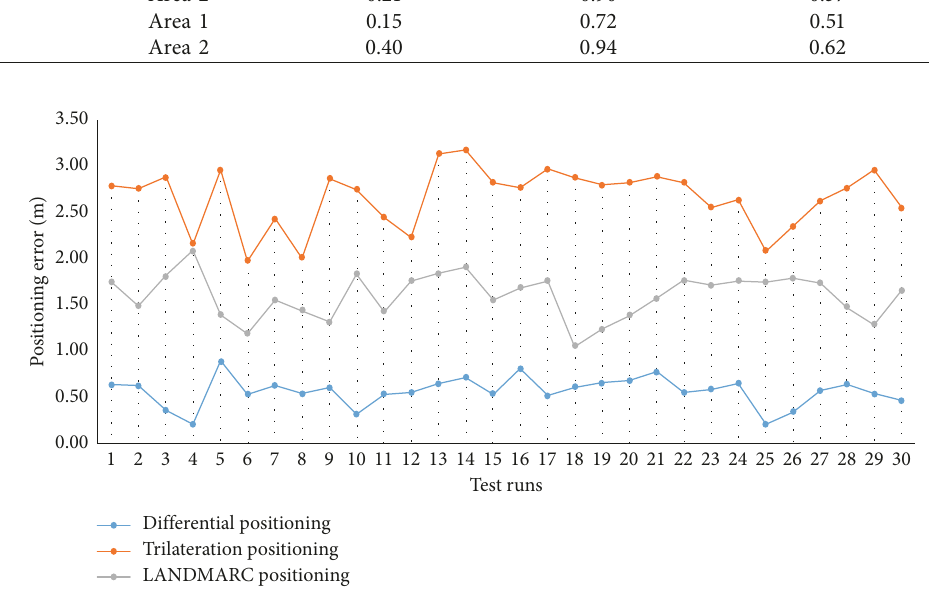
Figure 26: Positioning algorithms’ error comparative results (RFID